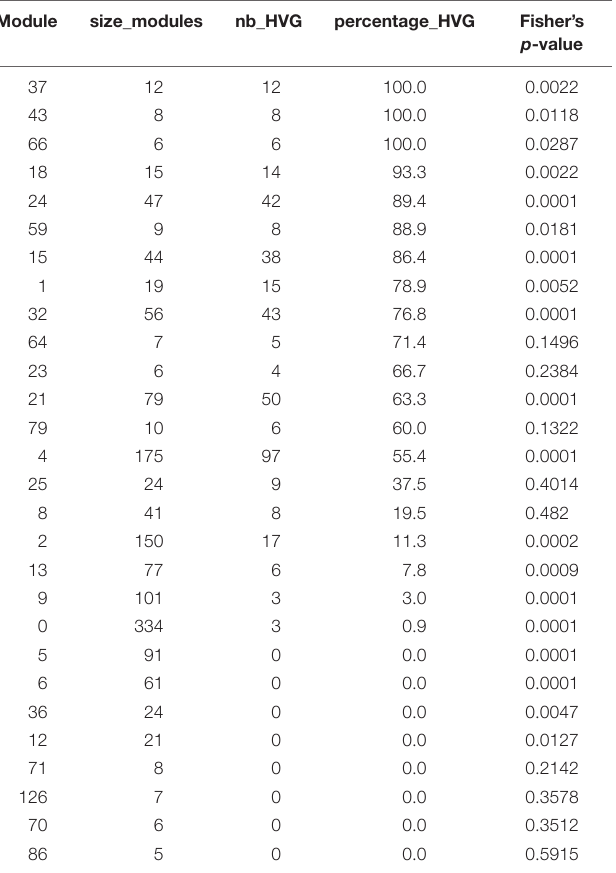
TABLE 2 | Number and percentage in each module of genes also detected in the averaged time course network, for modules with at least five